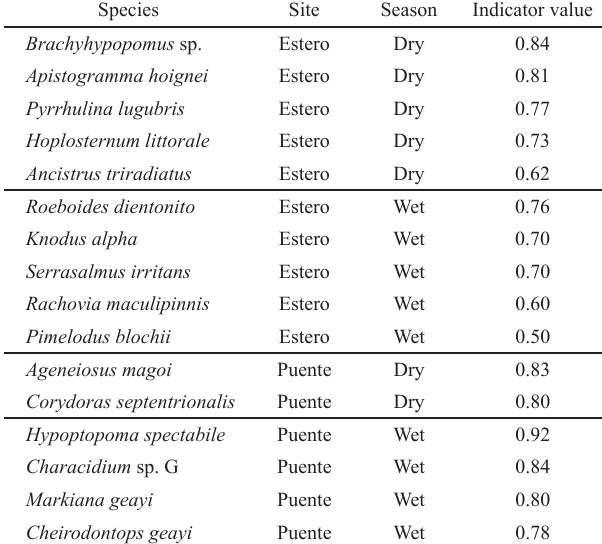
Tab. 2. Summary of indicator species for sites along the longitudinal gradient of Caño Maraca during dry and wet seasons. Only species with statistically significant values (p < 0.05) are shown; indicator values range from 0 to 1, with 1 representing a perfect indicator of a site and